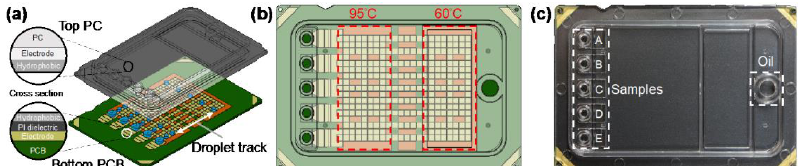
Figure 5. Digital microfluidic cartridge for qPCR of SARS-CoV-2 testing: ( a ) schematic diagram of the ink cartridge with the droplet trajectory; ( b ) design of the driving and reservoir electrodes; ( c ) schematic diagram of the sample inlet position. Reproduced with permission from Kuan, L, H., Micromachines ; published by MDPI, 2022